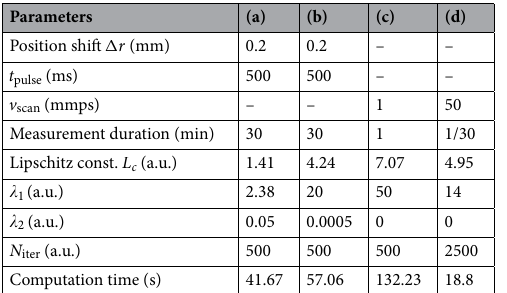
Table 1. Chosen experimental and processing parameters to obtain the IJOSP results (red curves) in Fig. 6.